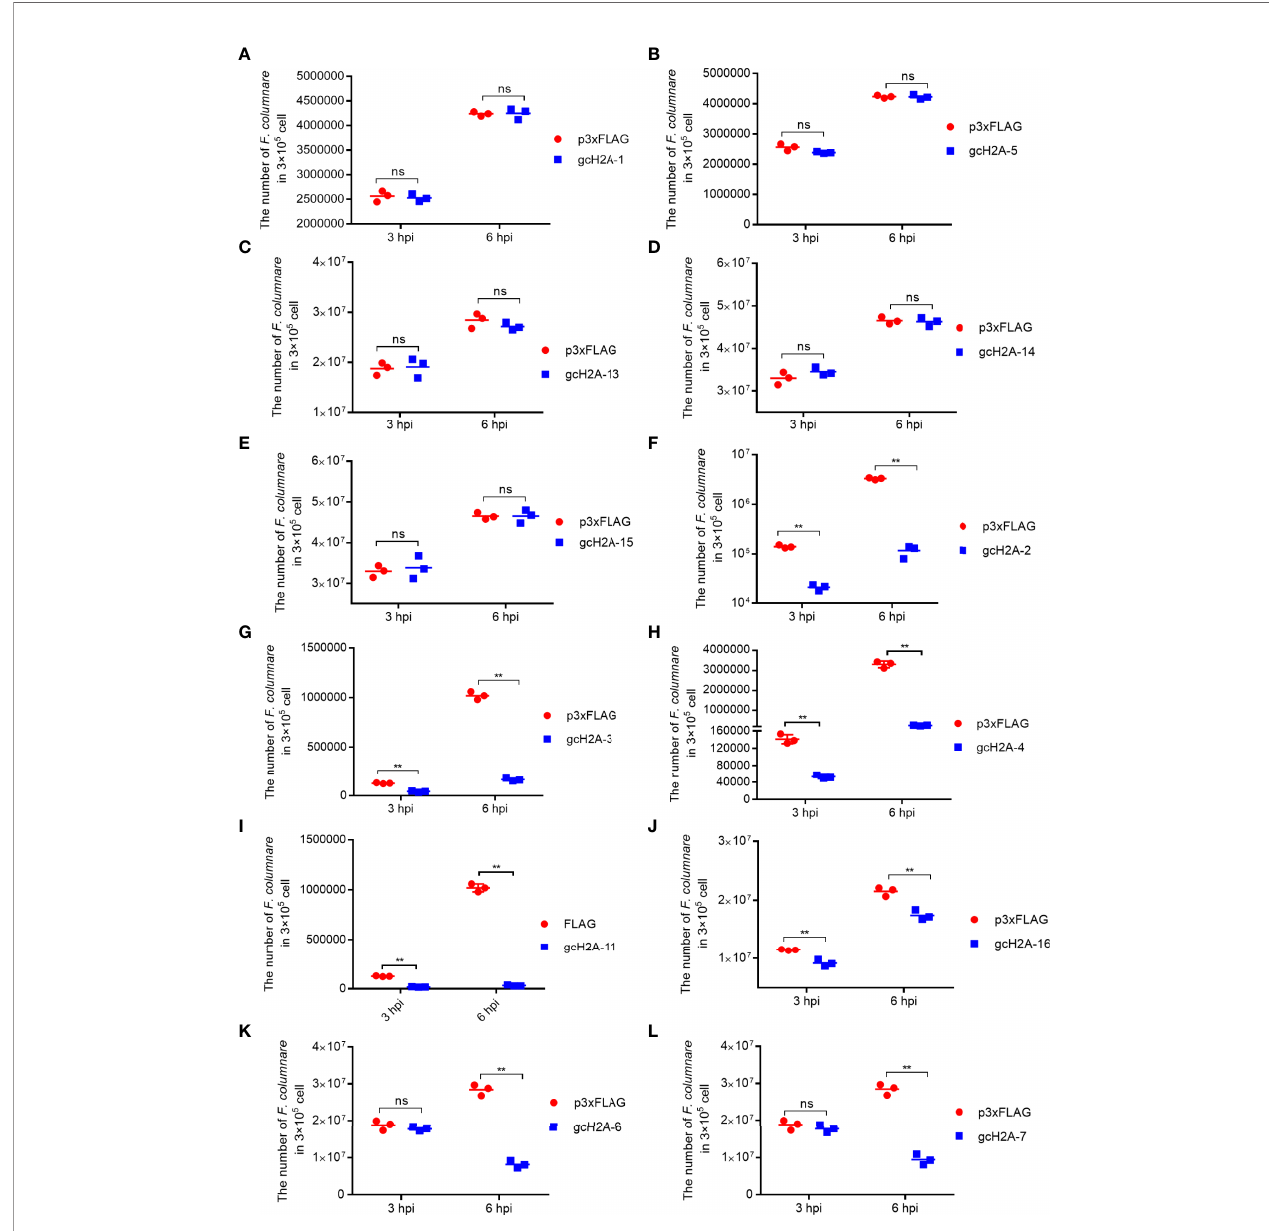
FIGURE 2 | The effects of grass carp histone H2A variants in bacterial infection. (A – E) No signi fi cant effects of gcH2A-1, gcH2A-5, gcH2A-13, gcH2A-14 and gcH2A-15 on the proliferation of F. columnare in vitro . (F – J) The antibacterial effects of gcH2A-2, gcH2A-3, gcH2A-4, gcH2A-11 and gcH2A-16 both at 3 hpi and 6 hpi. (K, L) The antibacterial effects of gcH2A-6 and gcH2A-7 at 6 hpi. Data represented means ± SEM (n=3), and were tested for statistical signi fi cance. ** p < 0.01; ns, not signi fi cant. The asterisk above the bracket indicates statistical signi fi cance between the two groups connected by the sometimes detected when the cell lysates transformed with the expression. The recombinant plasmids (gcH2A-4 − PYD1 and PYD1 empty plasmid were detected with anti-V5 antibody, in gcH2A-11 − PYD1) were constructed successfully and validated addition to the predicted 25 kDa band of PYD1 protein by Bam H I/ Eco R I double restriction enzyme digestion ( Figure 3B ). Only a single band with an approximate 40 kDa ( Figure 3A ). The recombinant gcH2A-4 − PYD1 and gcH2A-11 − PYD1 were integrated into downstream of the GAL1 and T7 was detected in the cell lysates transformed with gcH2A-4 − PYD1 plasmid, and an approximate 50 kDa observed in the promoters of S. cerevisiae strain, and the expressions of gcH2A-4 − PYD1 and gcH2A-11 − PYD1 were induced by D-galactose. cell lysates transformed with gcH2A-11 − PYD1 plasmid ( Figure 3C ). The protein bands corresponding to gcH2A-4 Analysis of cell lysates by 10% SDS-PAGE electrophoresis − PYD1 and gcH2A-11 − PYD1 did not exist in the cell lysates showed that an obvious heteroband between 35~40 kDa was